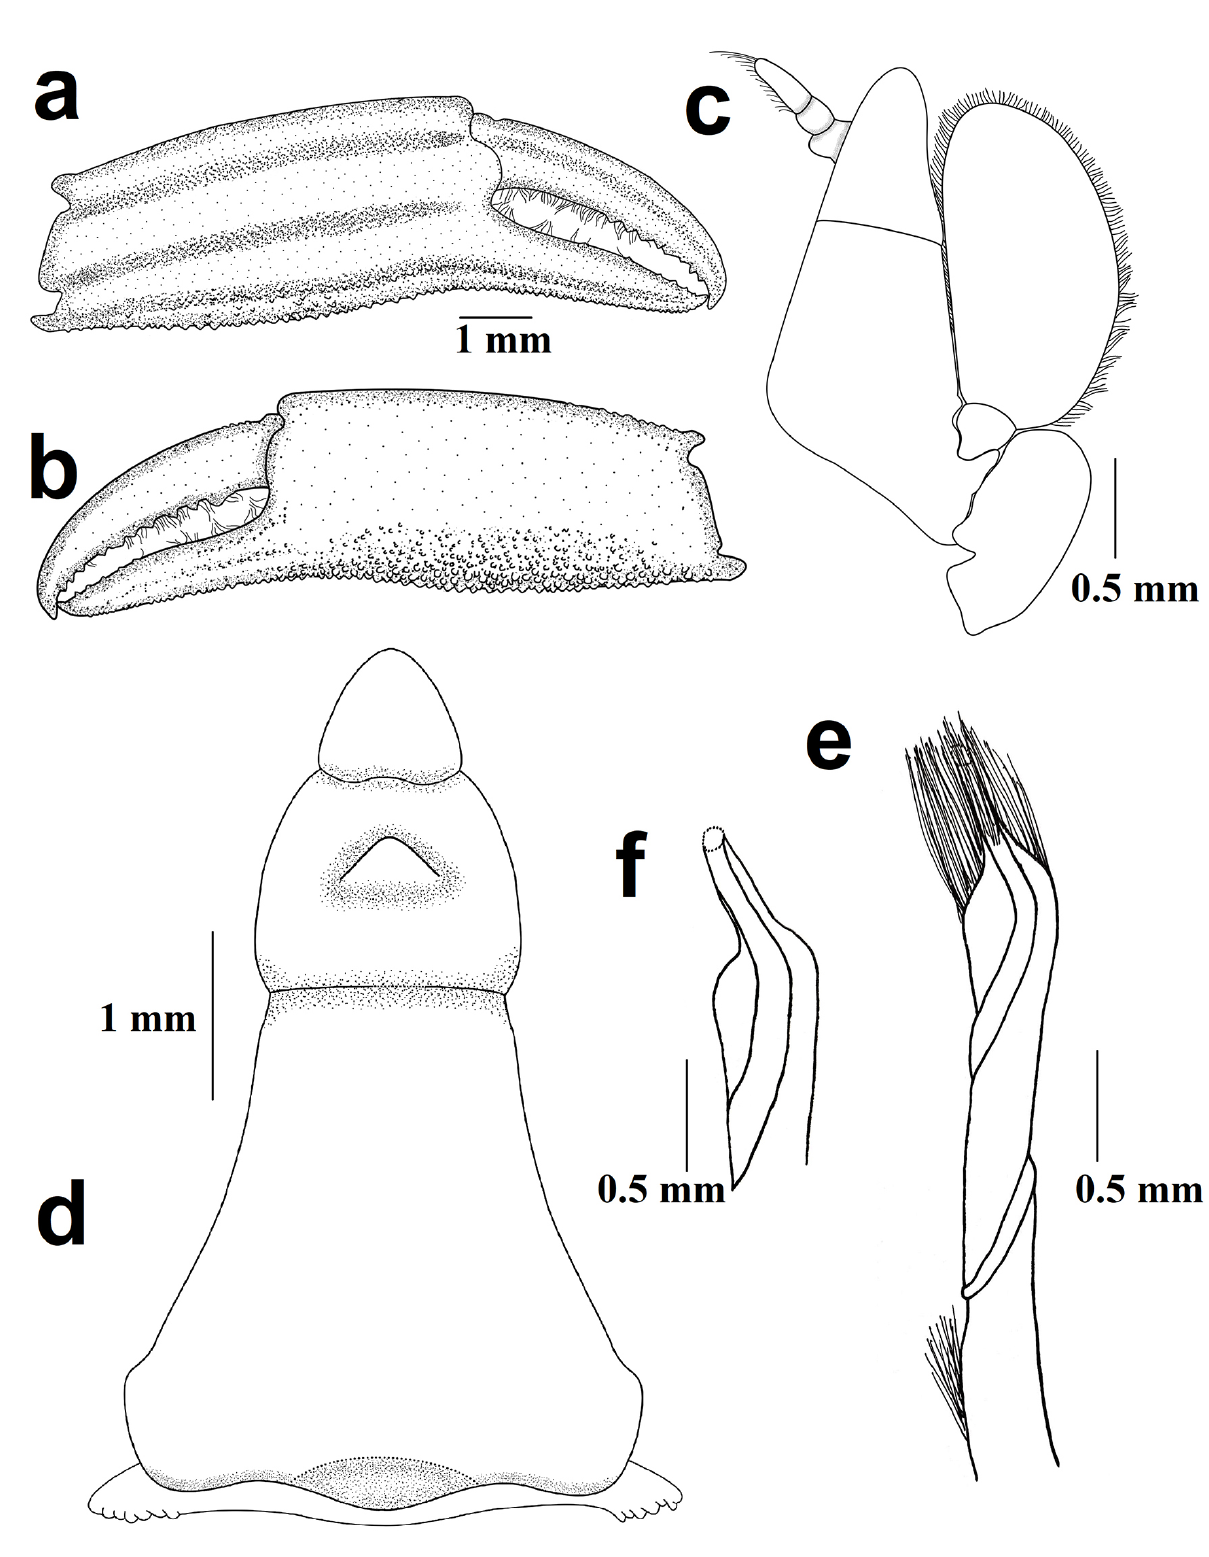
Figure 5. Bellayra persicum gen. nov., sp. nov., holotype, male (CL 7.88 mm, CB 7.83 mm) (ZSI-896/10). a , Right chela, outer view; b , right chela, inner view; c , left third maxilliped, outer view; d , abdomen; e , G1 abdominal view; f , G1 apical lobe (setae